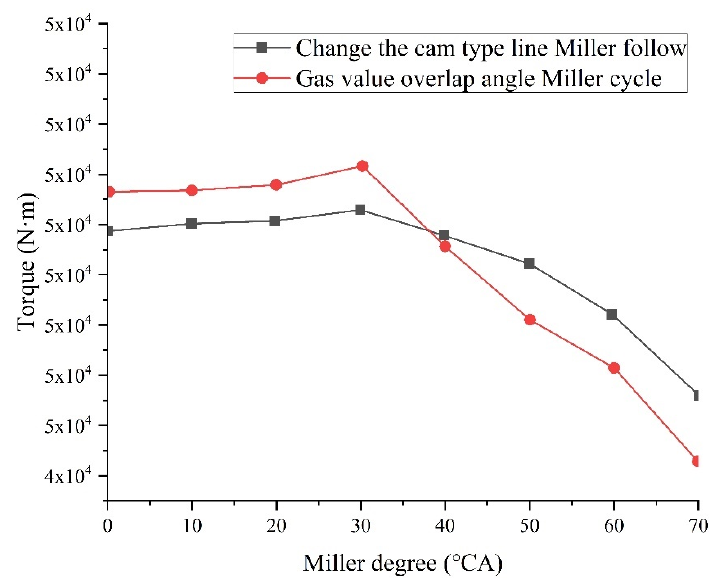
Figure 18. Comparison diagram of two Miller cycle torque.